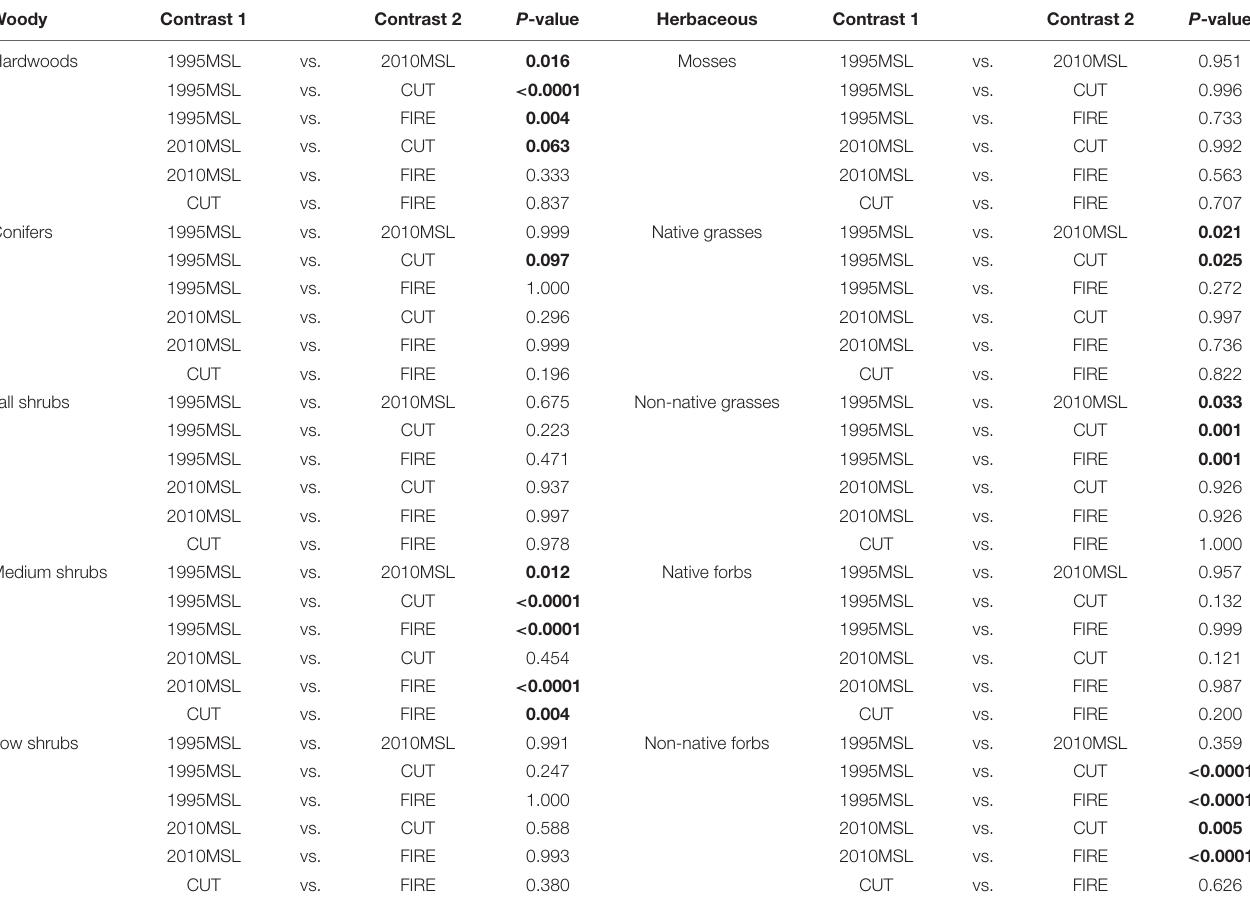
TABLE 5 | Pairwise comparison of similarity in community composition (percent cover) by species groups (hardwoods, conifers, shrubs, mosses, grasses, forbs) and site type (1995MSL, 2010MSL, CUT, FIRE).